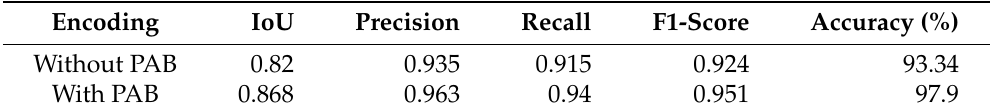
Table 3. Effect of positional